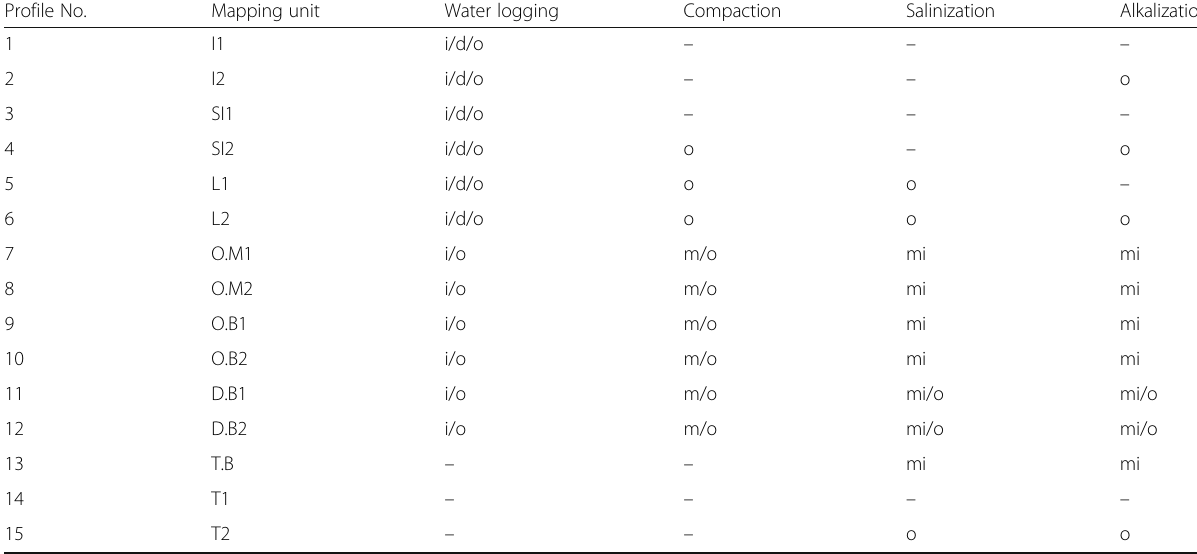
Table 12 Causative factors of human-induced land degradation types Profile